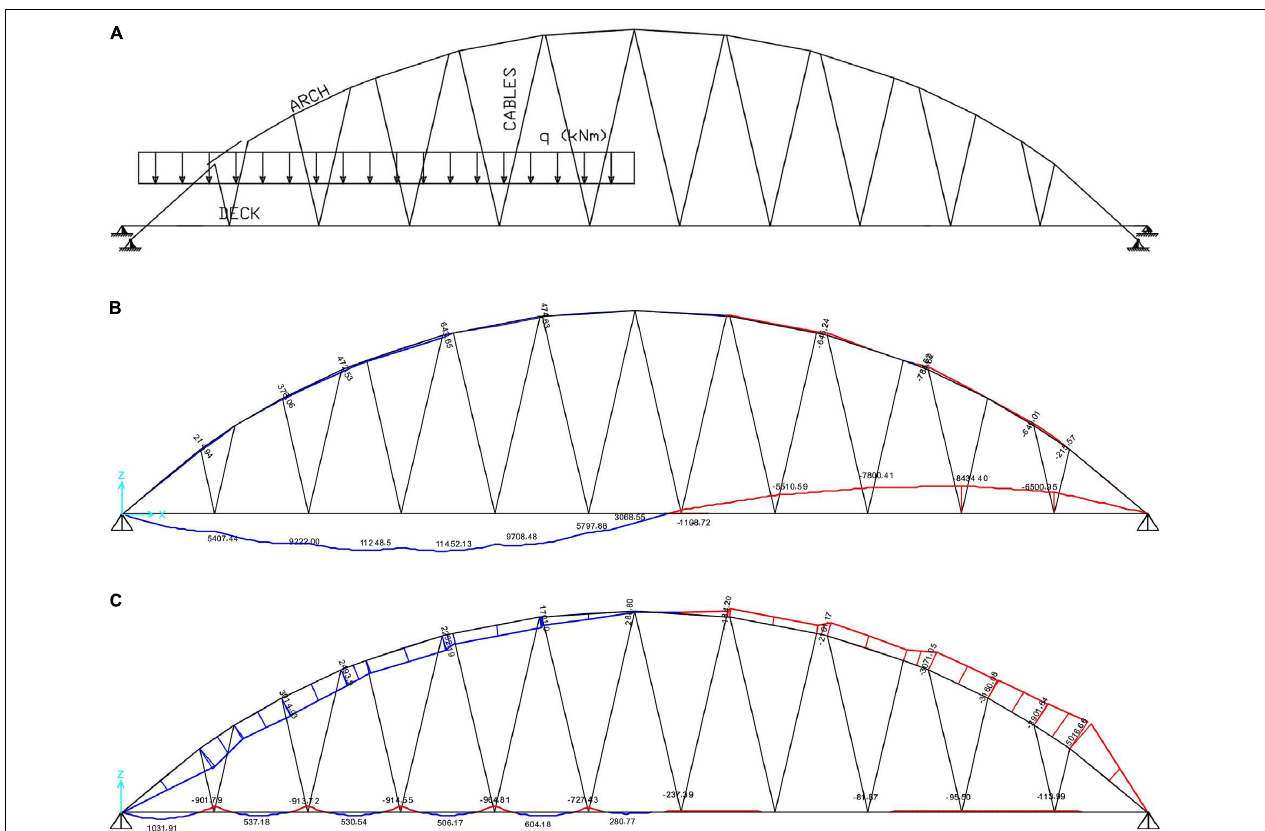
FIGURE 8 | Numerical results for load case 3. (A) Load case 3: action of a PUDL over one half of the deck. (B) BMD over the deck and the arch under zero cable pre-tensioning. (C) TBMD produced by the optimal cable pre-tensioning.